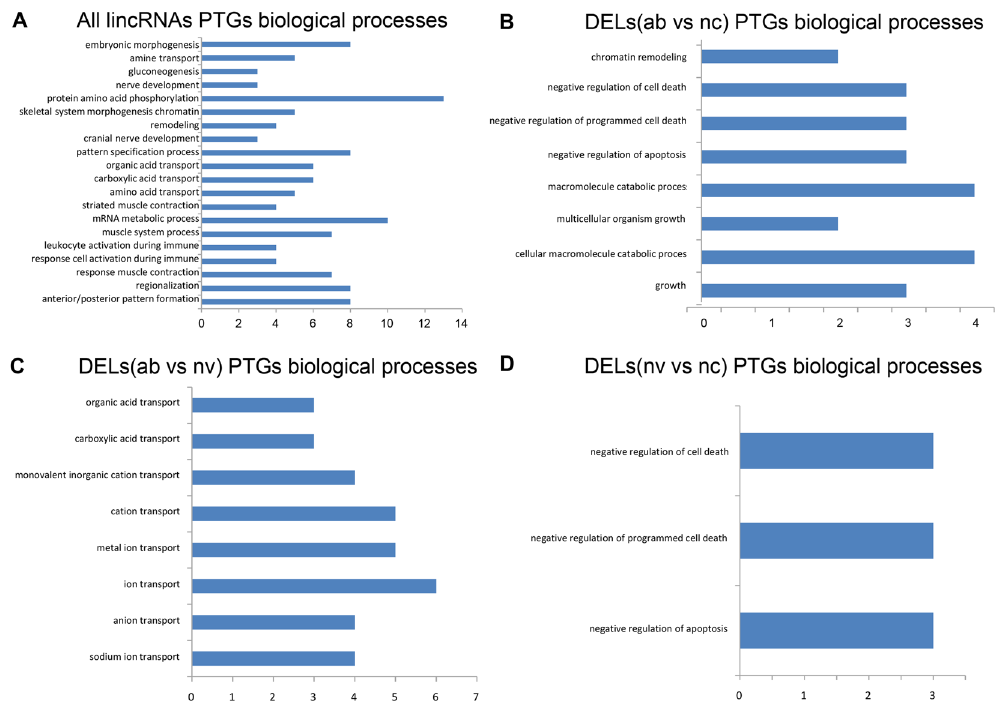
Figure 6. Gene ontology and pathway analysis of PTGs of lincRNAs. The x axis indicates the number of genes, and the y axis indicates different biological processes. ab: the ab group; nc: the nc group; nv: the nv group. ( A ) Biological processes of all lincRNAs PTGs; ( B ) Biological processes of PTGs of DELs (ab vs nc); ( C ) Biological processes of PTGs of DELs (ab vs nv); ( D ) Biological processes of PTGs of DELs (nv vs nc).